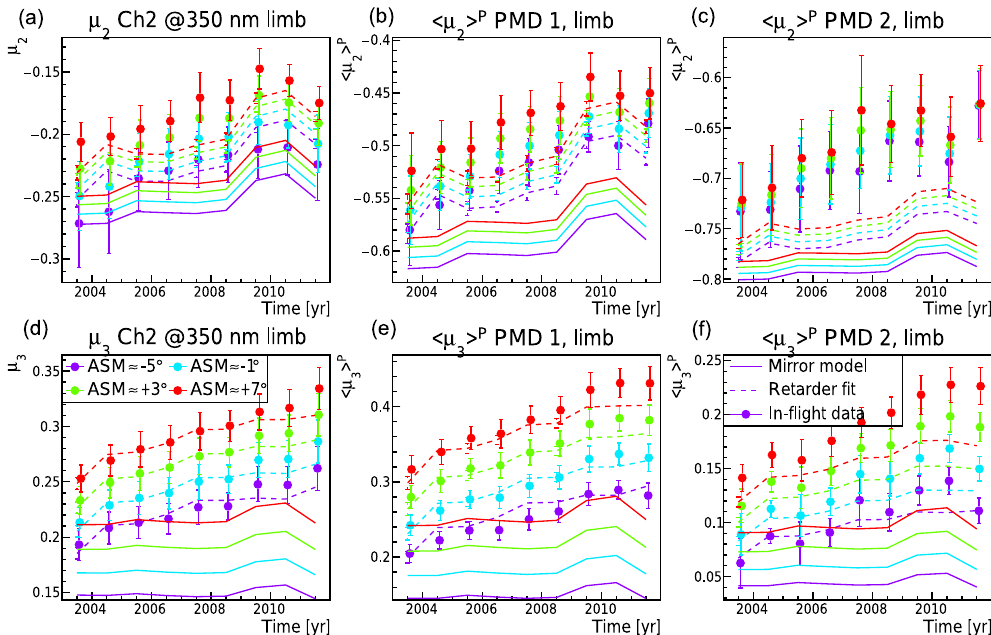
Figure 17. Time dependence of in-flight end-to-end Mueller matrix elements µ 2 (a, b, c) and µ 3 (d, e, f) for limb at TH ≈ 28km for four selected ASM angles from measurements (data points), the scan mirror model without the retarder (solid lines) and the mirror model with the retarder (dashed lines). The error bars include statistical and total systematic errors. (a, d) Channel 2 feature; (b, e) PMD 1; (c, f) PMD 2. The color code signifies the ASM scan angle bin ( − 5, − 1, + 3, + 7 ◦ ), increasing on a rainbow color